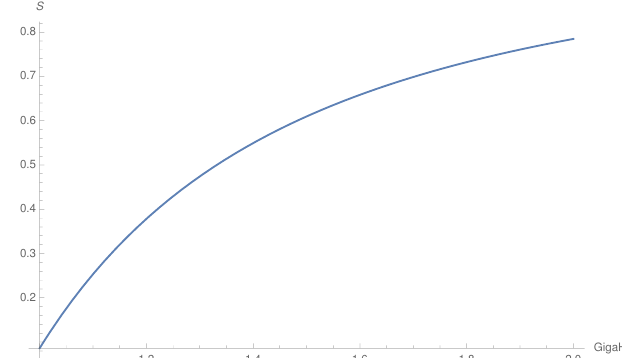
Figure 1. Plot of the Stix function S ( ω )